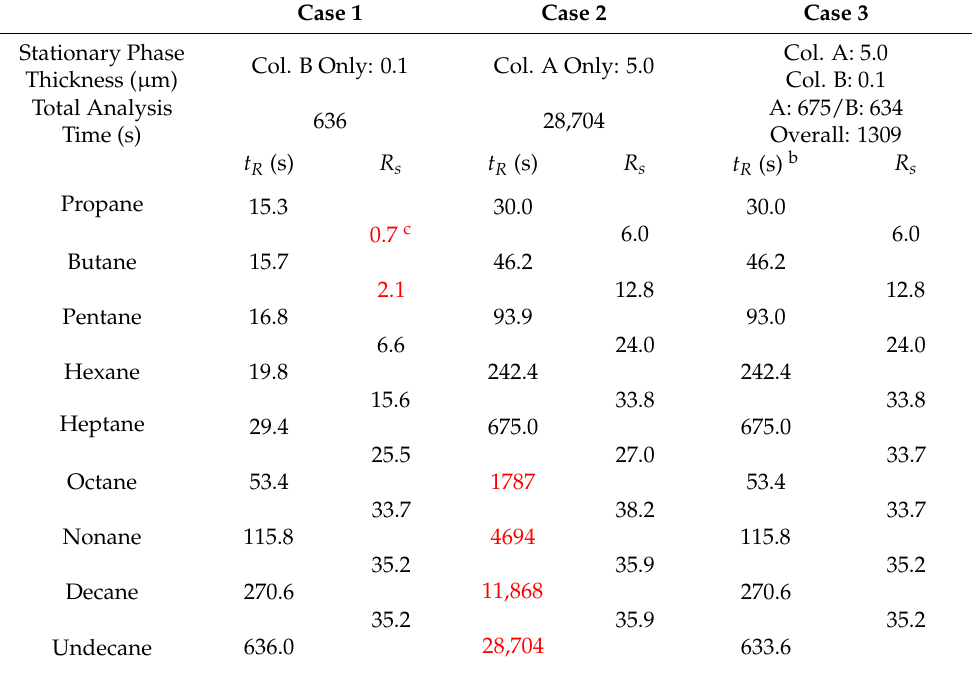
Table 2. Computed a values of retention times of various alkanes and separation resolution between pairs of alkanes at 25 ◦ C for Cases